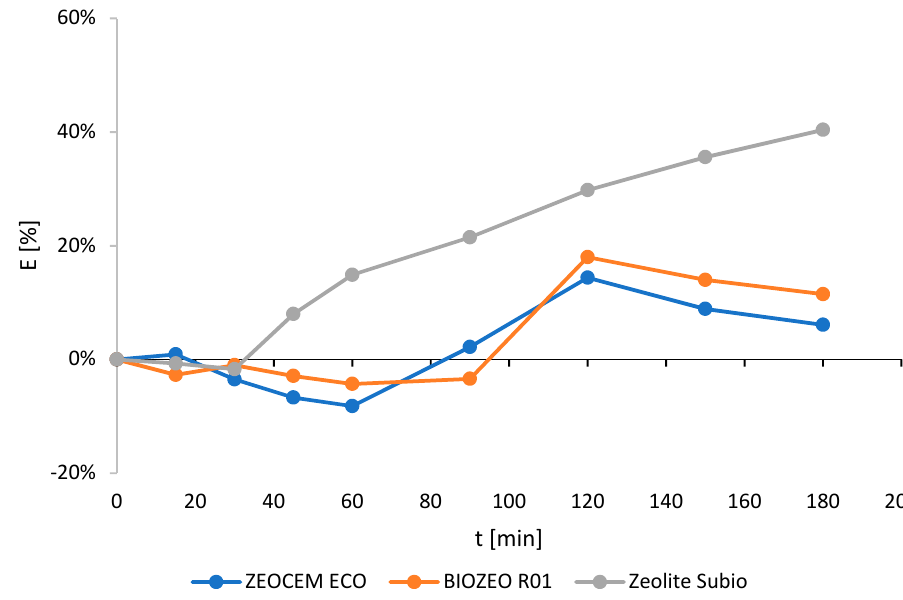
Figure 1. The ammonium ions removal e ffi ciency (E) for Zeocem Eco, Biozeo R01, and Zeolite Subio.